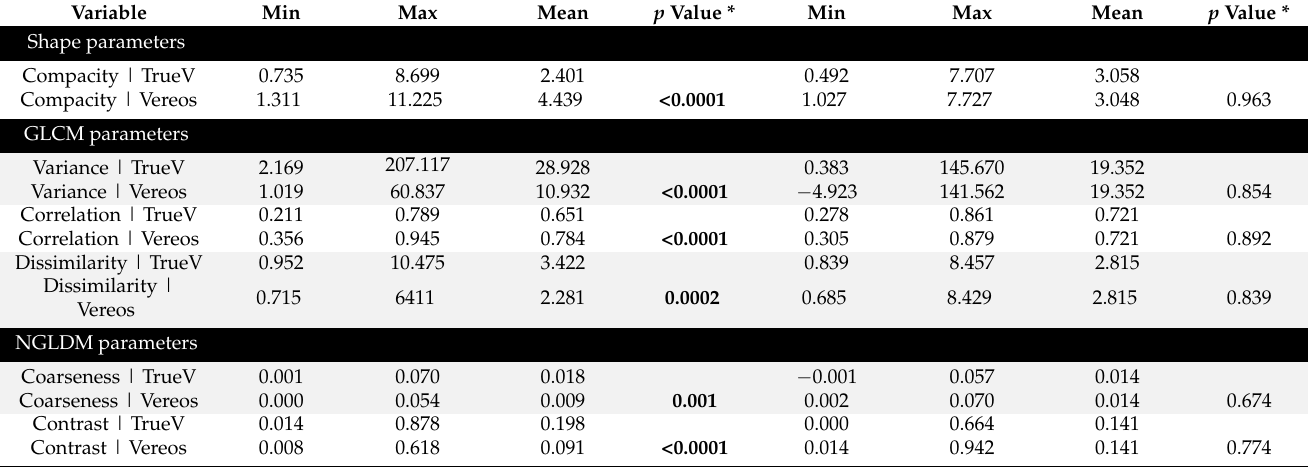
Table 2. Comparison of TrueV and Vereos positron emission tomography quantitative variables before and after the ComBat harmonisation process. The only variables found to be significantly different between the TrueV and the Vereos systems before the ComBat harmonisation process are presented here. To see the data for all variables, please refer to the exhaustive supplemental Table S1 (* according to Bonferroni correction, a p -value < 0.0016 was considered